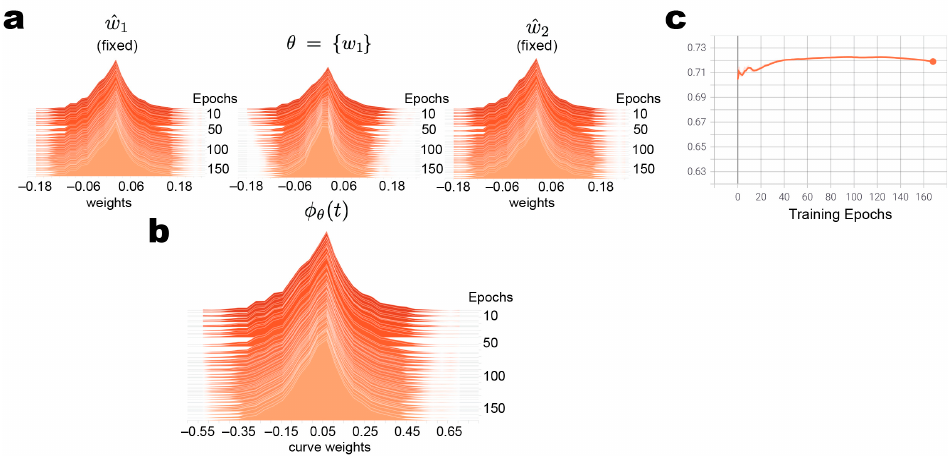
Figure 3. PCA subspace model parameter distributions and test performance. ( a ) Parameter distributions during curve-fitting (during training epochs) showing the fixed endpoints (outside distributions) and the optimized parameter. ( b ) Distribution of parameters within calibrated curve. ( c ) Test perfor- mance (AUPR) during curve-fitting shows stable performance during the optimization of the free parameter θ